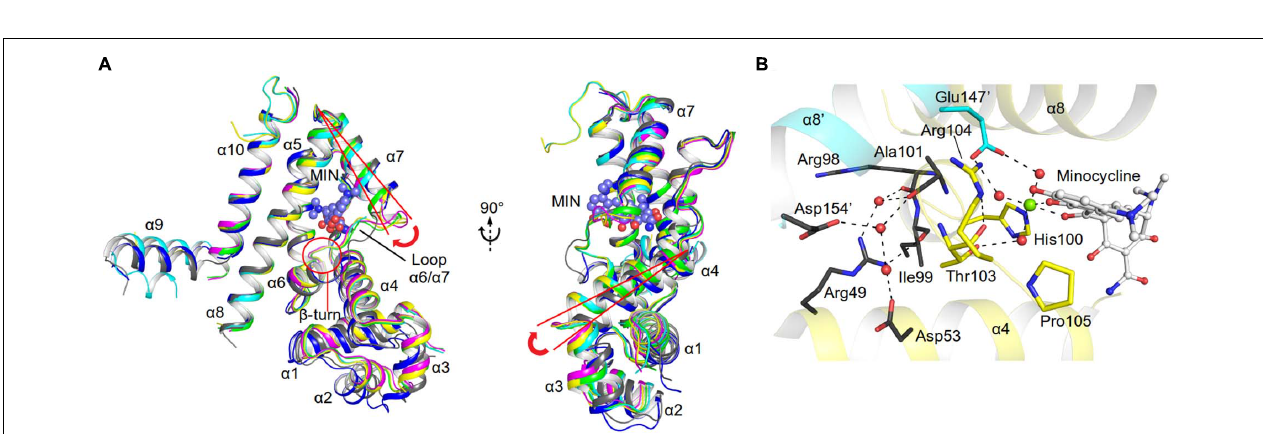
FIGURE 6 | Minocycline (MIN) binding induced conformational changes of AbTetR. (A) Conformational changes of the DNA binding domain of the unliganded AbTetR and the liganded Gln116Ala structures. Structural superimposition was performed based on the main chain atoms of helices α 8 and α 10 (Yu et al., 2010). (AbTetR-A: black, AbTetR-B: blue, Gln116Ala-A: green, Gln116Ala-B: cyan, Gln116Ala-C: magenta, Gln116Ala-D: yellow). (B) Water-mediated stabilization of the β -turn upon minocycline binding. Water molecules and the Mg 2 + are depicted as red and green spheres, respectively.